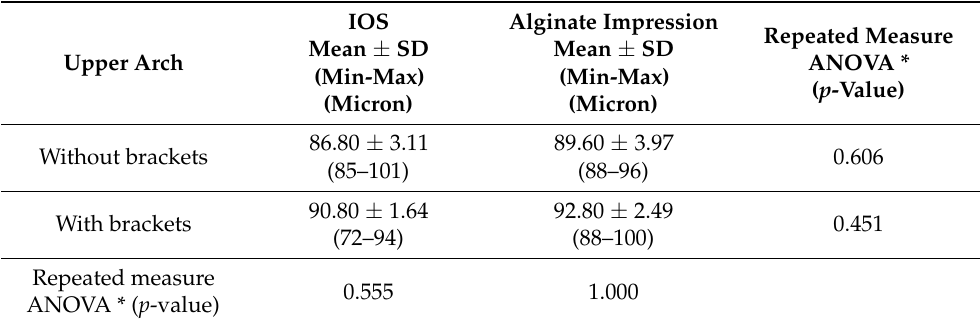
Table 1. Average surface deviation (mean difference and standard deviation) in measurements by IOS, alginate, and control in the upper